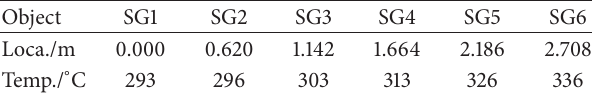
Table 9: Various T-H conditions for 5 × 5 spacer grids.